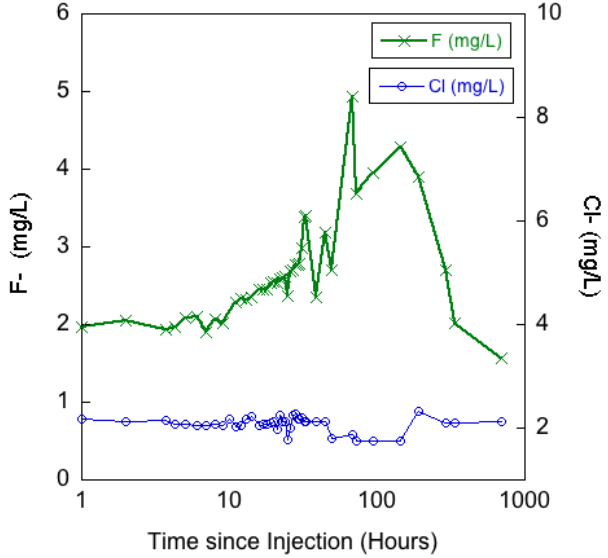
Figure 7. Fluoride (F − ) concentrations measured in the 517 Shaft. Background chloride (Cl − ) concentrations are plotted over the same time period. Time (x-axis) plotted as log